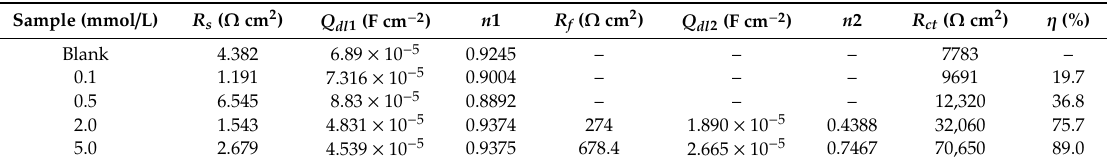
Table 1. EIS parameters for corrosion of Q235 carbon steel in simulated concrete solution (3.5% NaCl) without and with di ff erent inhibitor